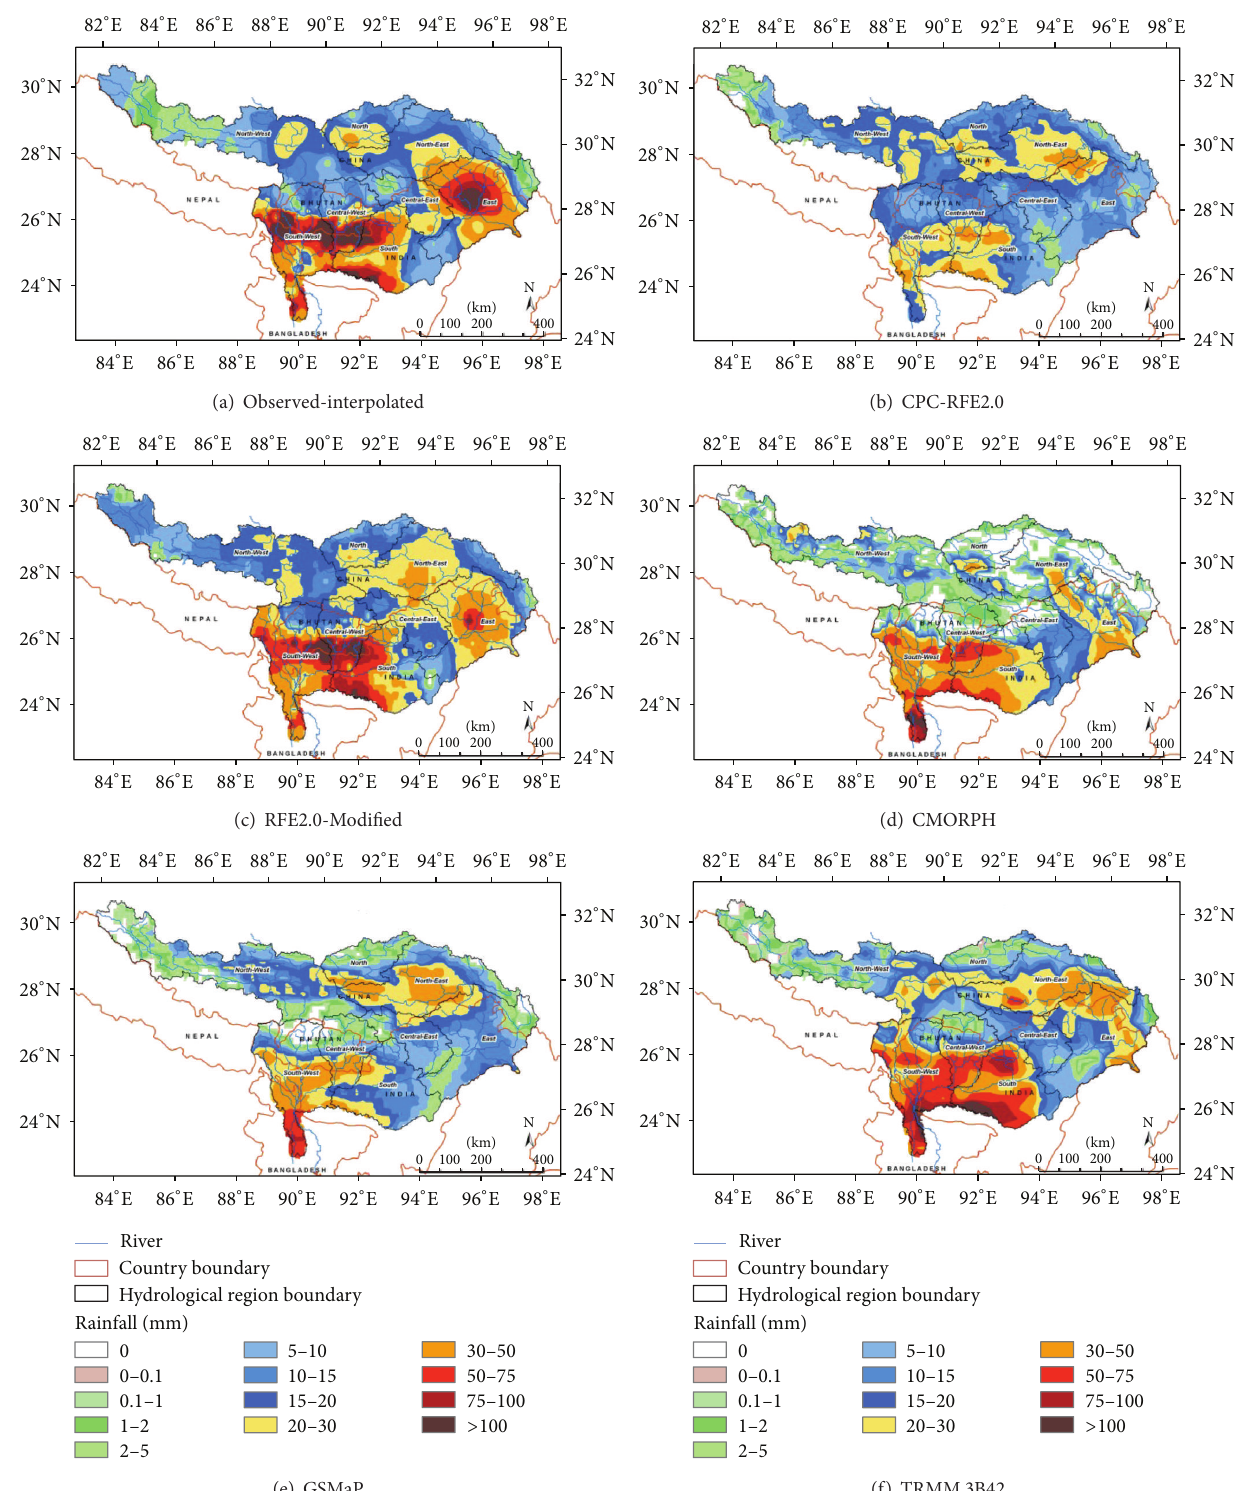
Figure 4: Rainfall distribution maps from six different products over the Brahmaputra Basin on July 8,